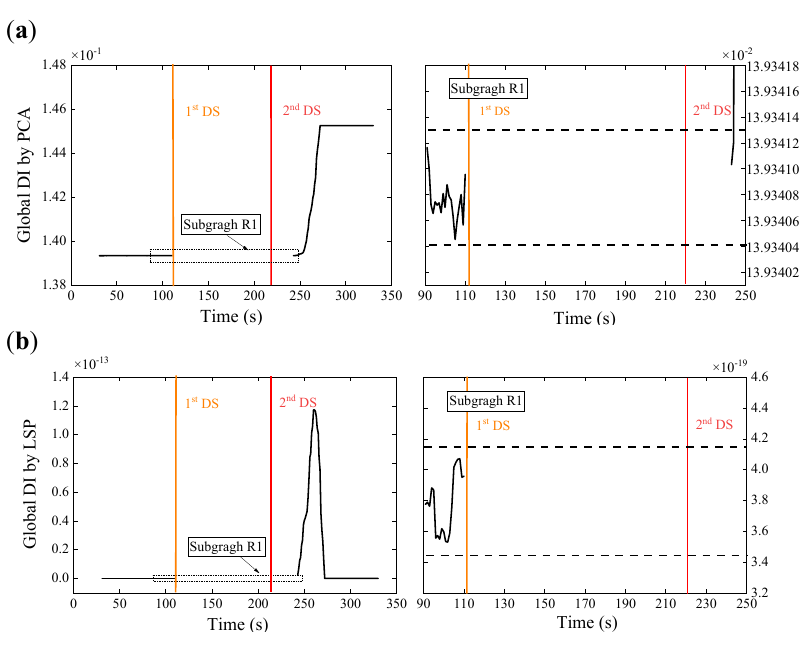
Figure 16. Results of damage detection for a data missing case referred to in Figures 7 and 14. The WPES-based ( a ) PCA and ( b ) LSP methods are demonstrated, respectively.